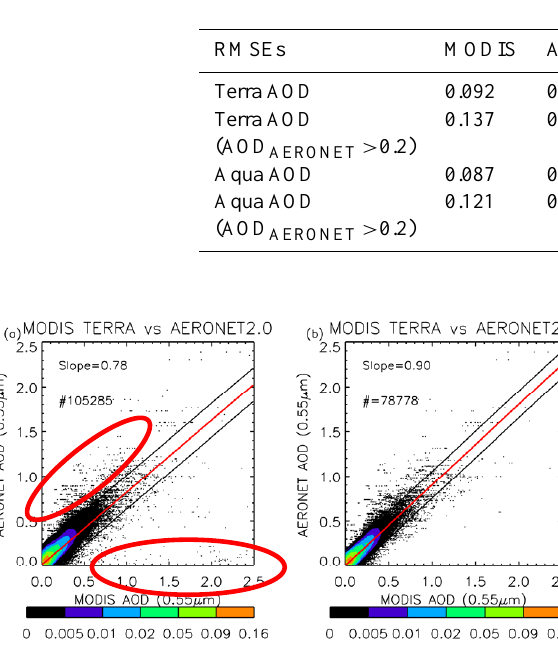
Table 3. The RMSEs between MODIS and AERONET AOD for total and high AOD cases (AOD AERONET > 0.2) using nine years of Terra and eight years of Aqua data.